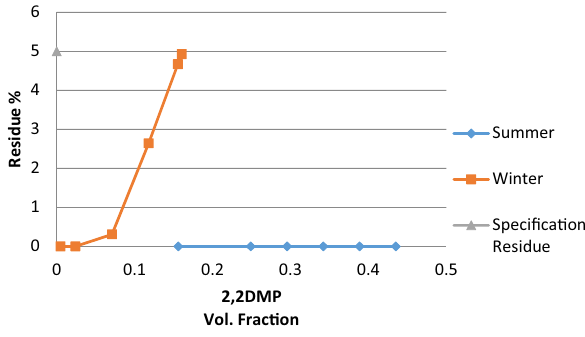
Fig. 36 Limitation of adding 2,2DMP to 20 vol% DME and